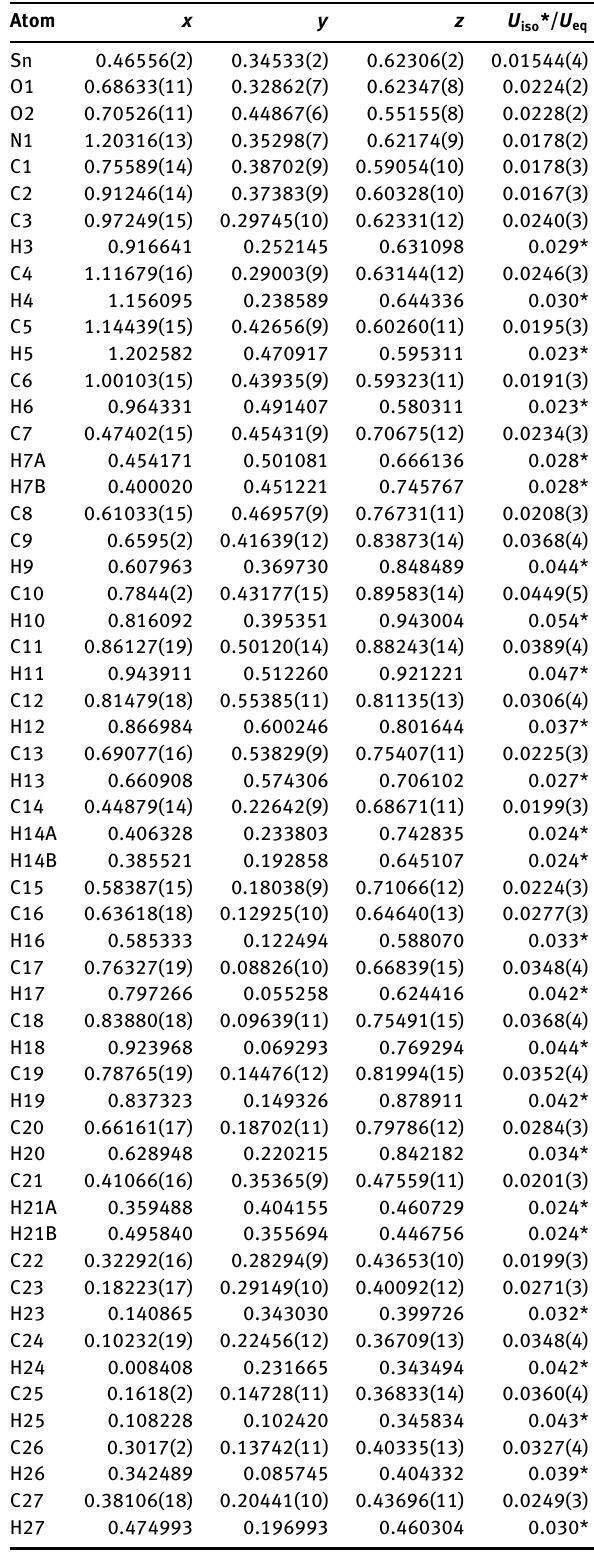
Table 2: Fractional atomic coordinates and isotropic or equivalent isotropic displacement parameters (Å 2